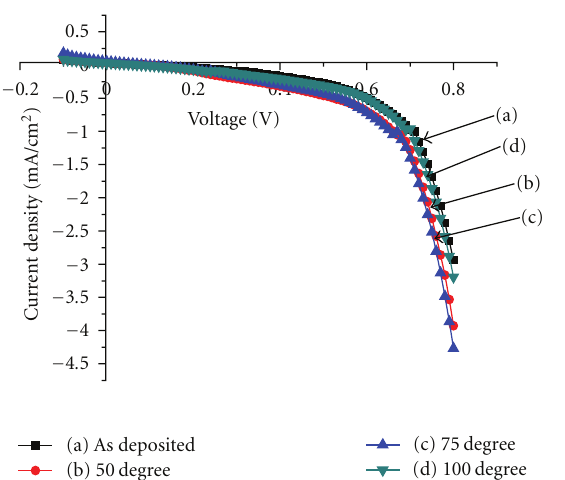
Figure 3: Measured current density-voltage ( J-V ) characteristics for nanocomposited MEH-PPV:CNTs at di ff erent heating temperature.